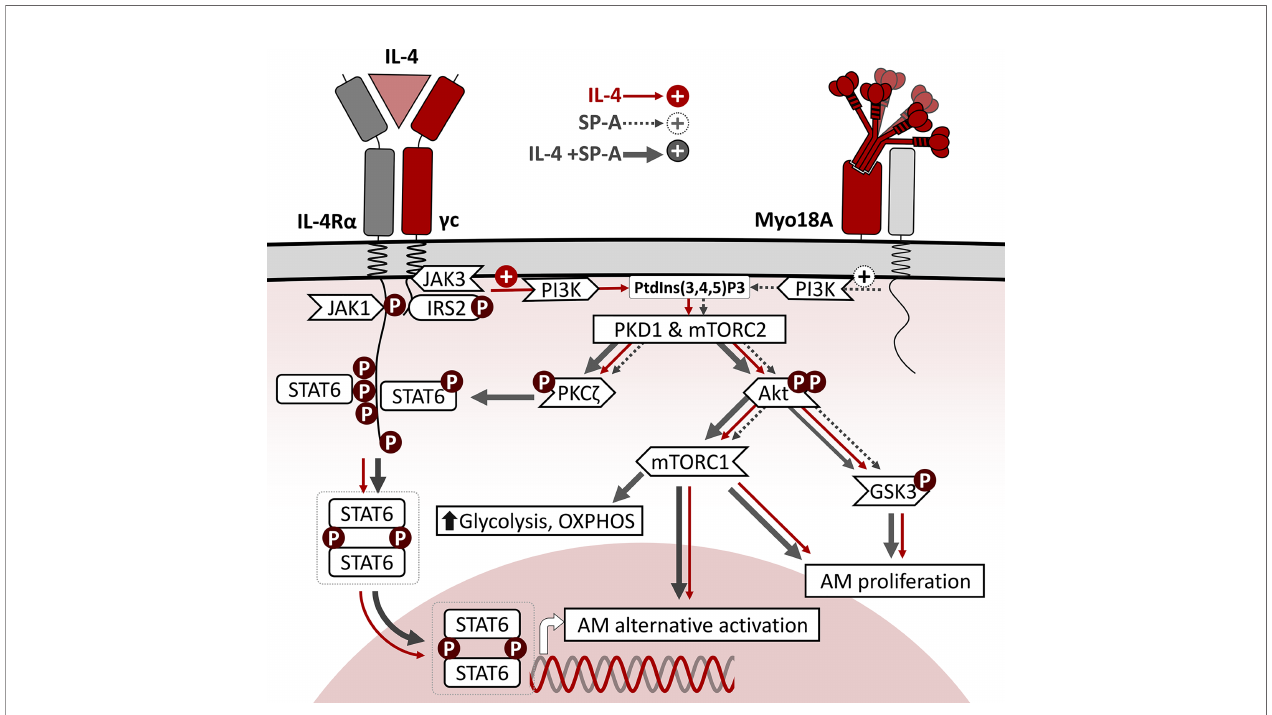
FIGURE 8 | Schematic representation of intracellular signaling pathways of IL-4, SP-A, and IL-4+SP-A in alveolar macrophages. The binding of IL-4 to the ectodomains of IL-4R a and g c chains results in phosphorylation of critical tyrosine residues in IL-4R a cytosolic domain, which serves as docking sites for SH domains of intracellular signaling molecules such as STAT6 and IRS2. Once STAT6 is activated by phosphorylation, they homodimerize via their Src homology 2 domains and translocate to the nucleus, where they bind to speci fi c DNA sequences that induce expression of genes associated with alternative activation. In parallel, ef fi cient tyrosine phosphorylation of IRS2 triggers the PI3K/Akt pathway, associated to the plasma and/or endosomal membranes. This signaling pathway activates cell proliferation and AM alternative activation. SP-A, via the Myo18A receptor, activates PI3K, Akt, mTORC1, and PKC z , and inactivates GSK3 a / b by phosphorylation, but cannot activate arginase-1 activity or AM proliferation. The combined effects of IL-4 and SP-A on the mTORC1 and GSK3 branches of PI3K-Akt signaling contribute to increased AM proliferation and alternative activation. Consistent with mTORC1 activation, SP-A+IL-4 synergistically increased mitochondrial respiration and glycolysis in AMs. In addition, SP-A+IL-4-mediated PKC z signaling seems to intersect PI3K activation with STAT6 phosphorylation, increasing alternative activation of IL-4-stimulated